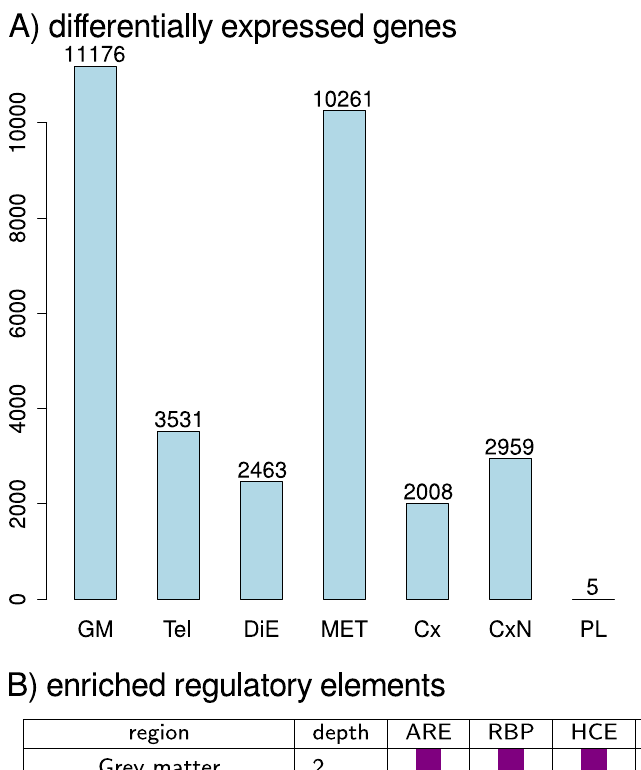
6 Scientific RepoRts | 7: 5776 | DOI:10.1038/s41598-017-06200-4